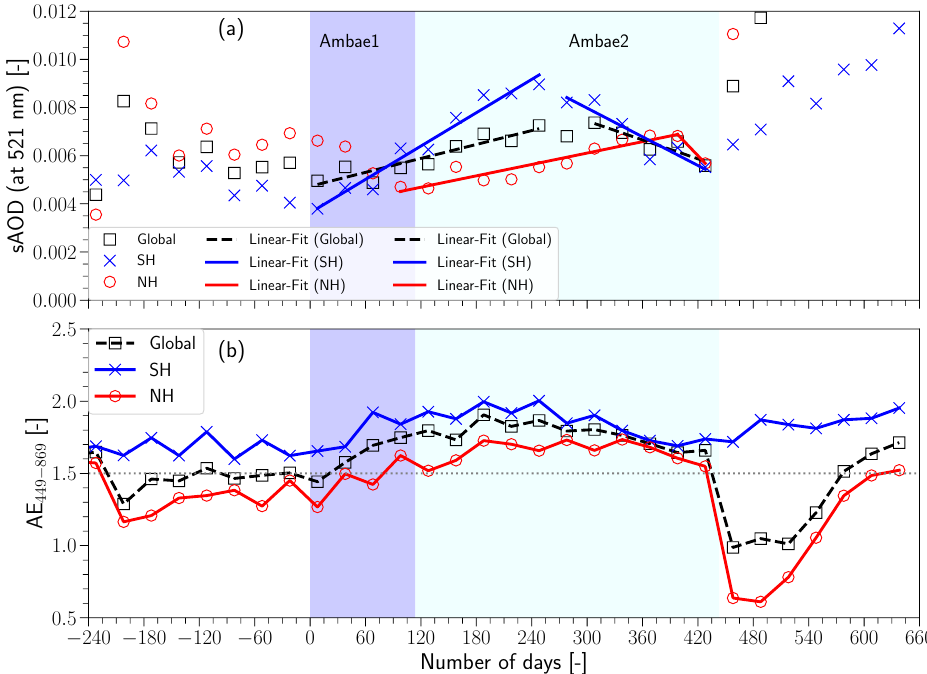
Figure 4. Time evolution (involving growth and decay characteristics) of ( a ) sAOD (at 521 nm), and ( b ) AE 449 869 for the global, SH, and NH regions comprising the first and second Ambae volcanic − eruption periods. The light blue and azure-shaded background boxes correspond to the Ambae1 (5 April 2018, to 26 July 2018) and Ambae2 (27 July 2018, to 20 June 2019) periods. On the X-axis, the number of days is scaled with respect to the first eruption date of the Ambae volcano (i.e., 5 April 2018). Both the sAOD and AE 449 869 are independent of our inversion −